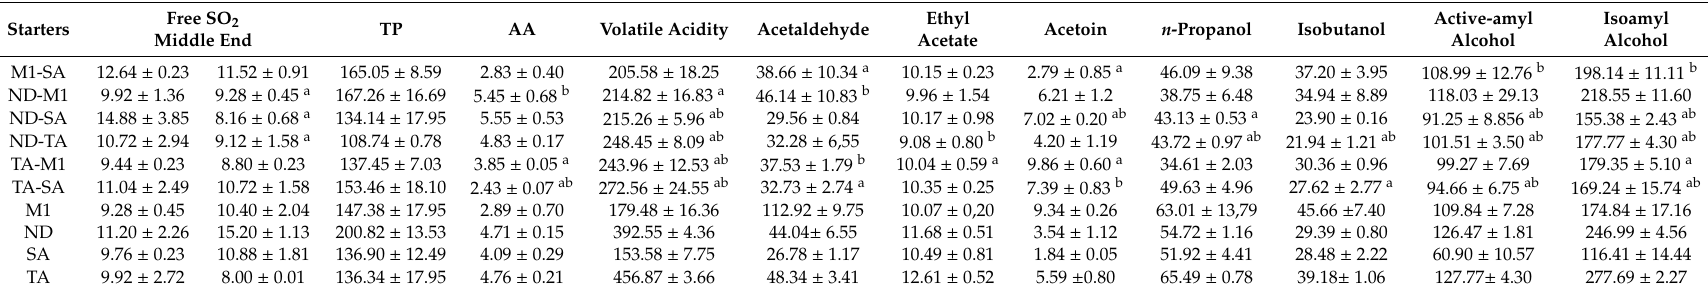
Table 2. Main oenological characteristics and secondary compound content (mg / L) of the experimental wines produced by the mixed cultures in comparison to those obtained by the pure cultures. For each parameter, superscript letters mean significant di ff erences at p ≤ 0.05 among each mixed fermentation and its single starters, i.e., MI-SA in comparison to M1 (first) and SA (second) single strains. Data are expressed as average ± SD of two independent